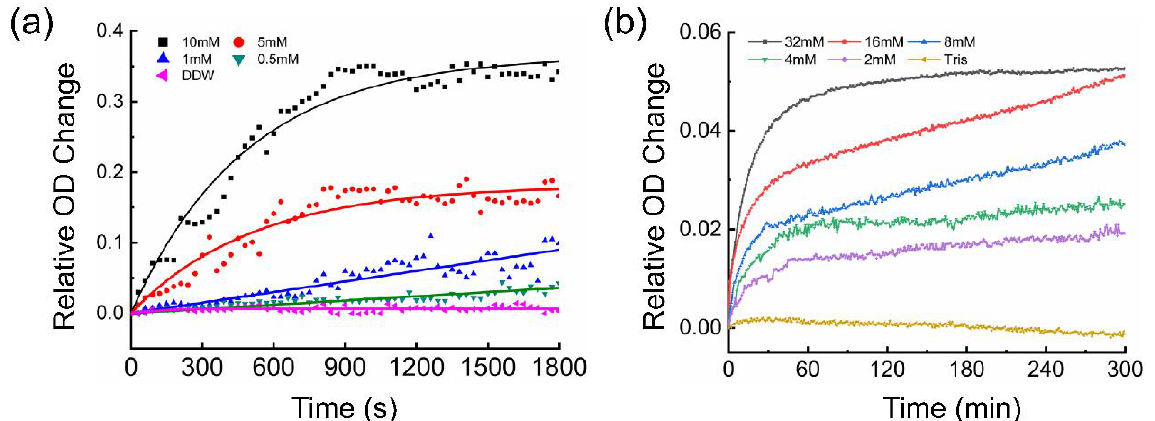
Figure 3. ( a ) Dynamic curve of the reaction of different concentrations of CaCl 2 and 10 mM Na 2 CO 3. (The solid lines represent the fitting curves.) ( b ) Dynamic curve of self-aggregation of different concentrations of the IPPA.